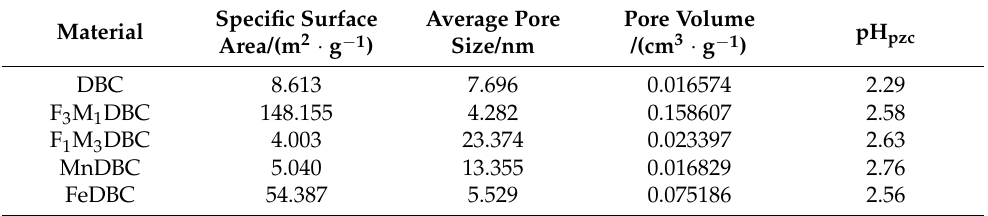
Table 1. Specific surface area, pore size, pore volume, and pHpzc of biochar before and after